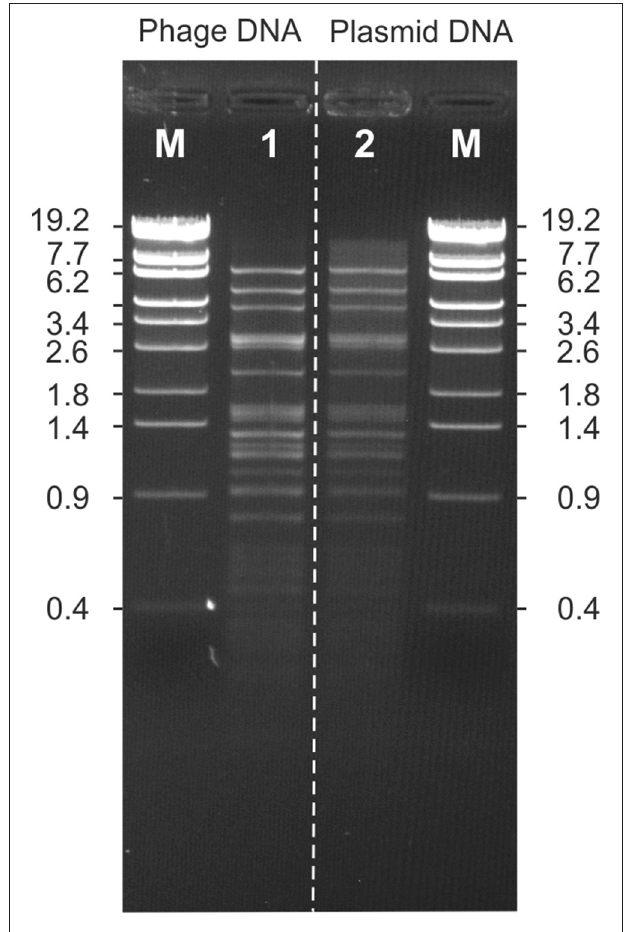
FIGURE 5 | Comparison of the EcoRV restriction patterns of the POI1126 phage (1) and plasmid prophage